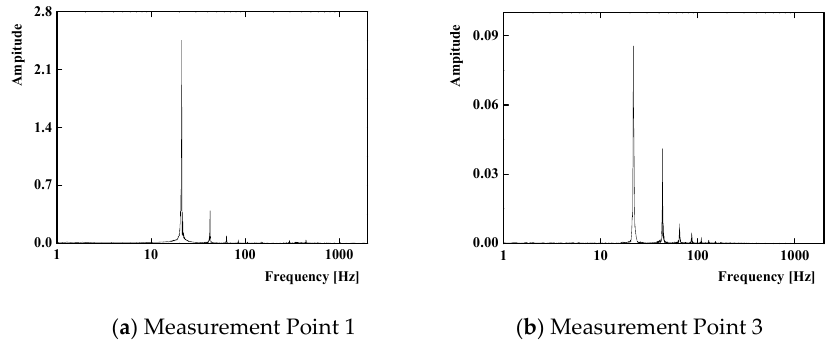
Figure 8. Fourier spectrum.